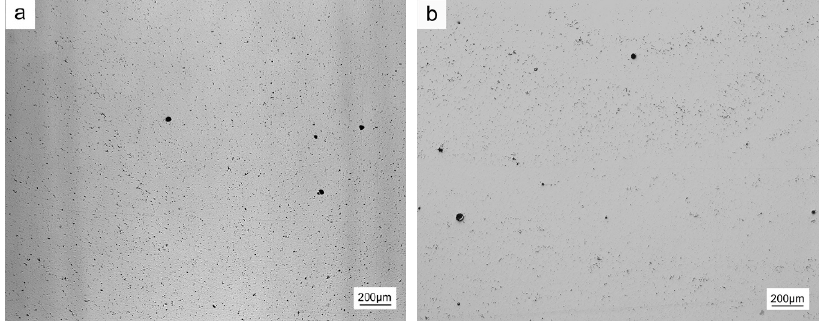
Figure 3. Optically observed porosity for the WAAM-fabricated ( a ) Al-Mg alloy and ( b ) Al-Mg-0.3Sc alloy.